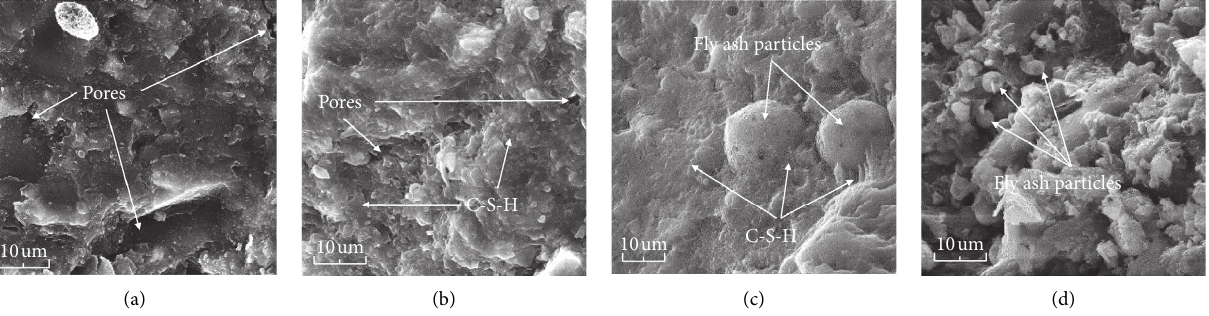
Figure 12: Microscopic rupture characteristics of concrete with fly ash replacement ratios of (a) 0, (b) 20, (c) 35, and (d) 50 wt%.